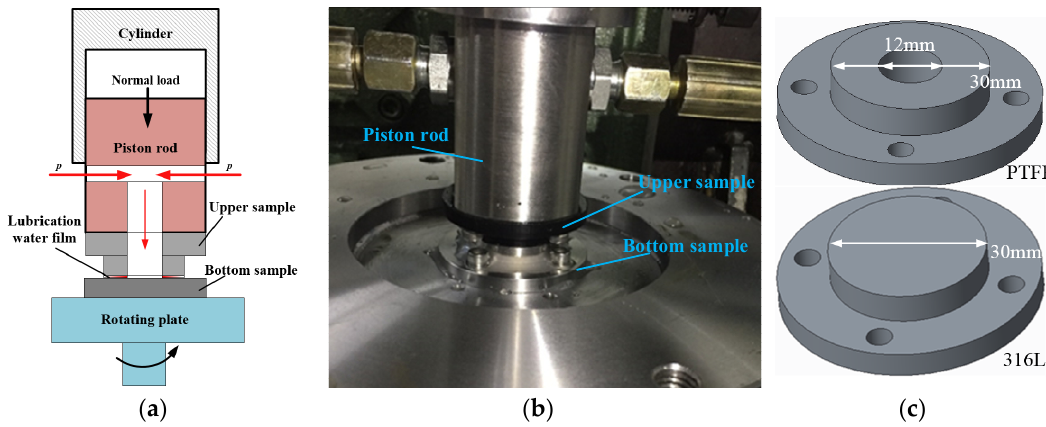
Figure 2. ( a ) The schematic of flat–flat friction pair experimental system; ( b ) the image of friction pair experimental system; ( c ) the 3D model and sizes of upper sample and bottom sample.